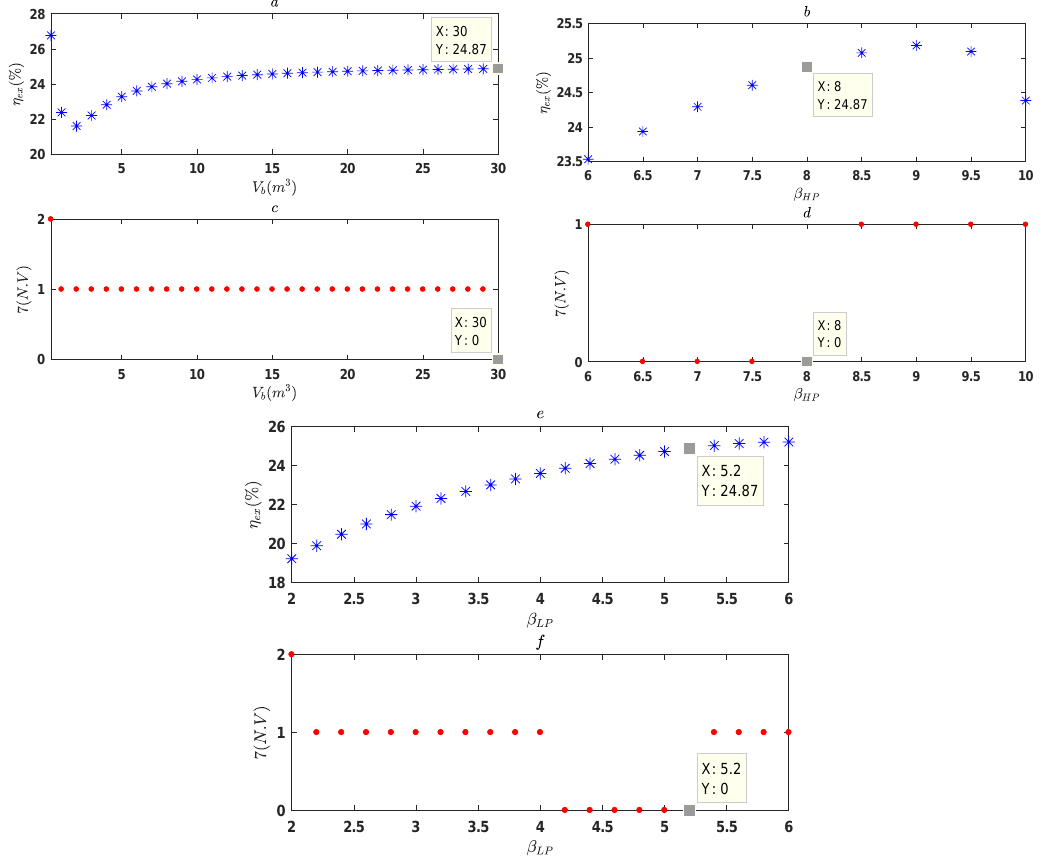
Figure 11. Variation of global exergy efficiency and number of violated constraints with volume of air storage tank ( a , c ), pressure ratio of high-pressure expansion stage ( b , d ) and low-pressure expansion stage ( e , f ) of pneumatic motor at optimal